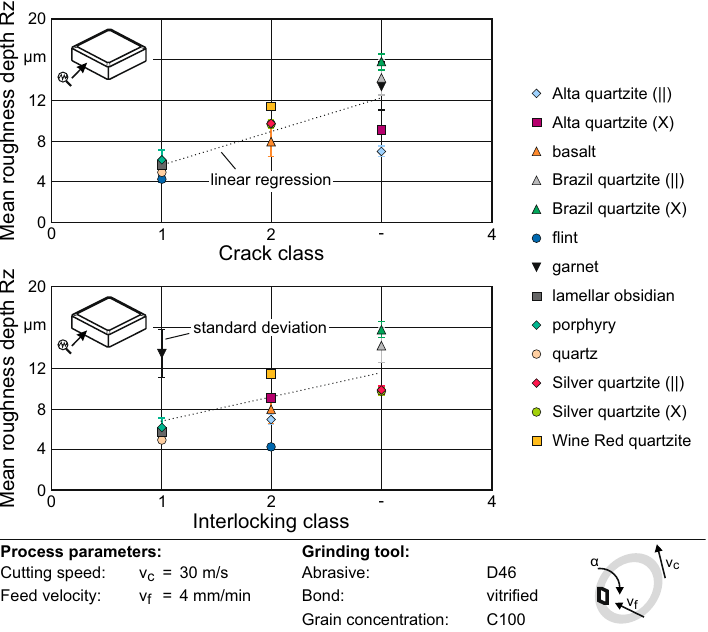
Fig. 14 Influence of interlock- ing and crack class on surface roughness at flank face after grinding